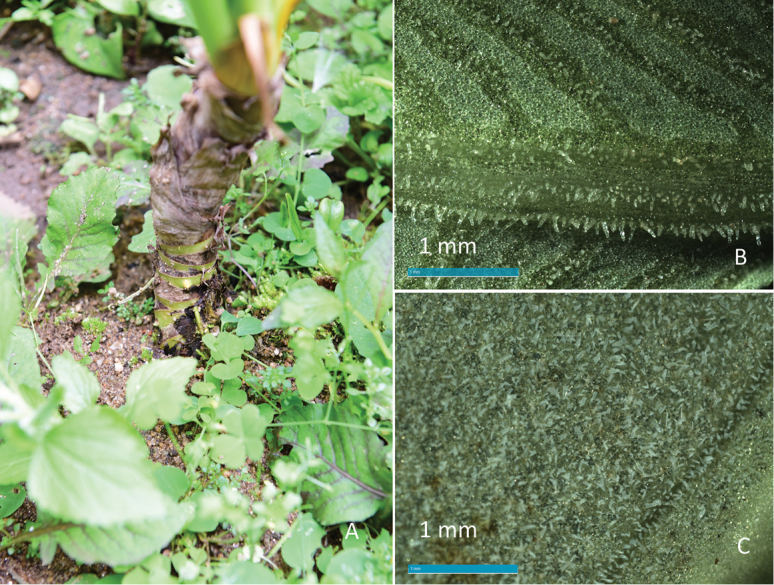
Stem of C.
kachinensis and morphological comparison between C.
menglaensis and C.
kachinensis. A stem of C.
kachinensisB lower surface of leaf ×100 of C.
menglaensisC lower surface of leaf ×100 of C.
kachinensis.